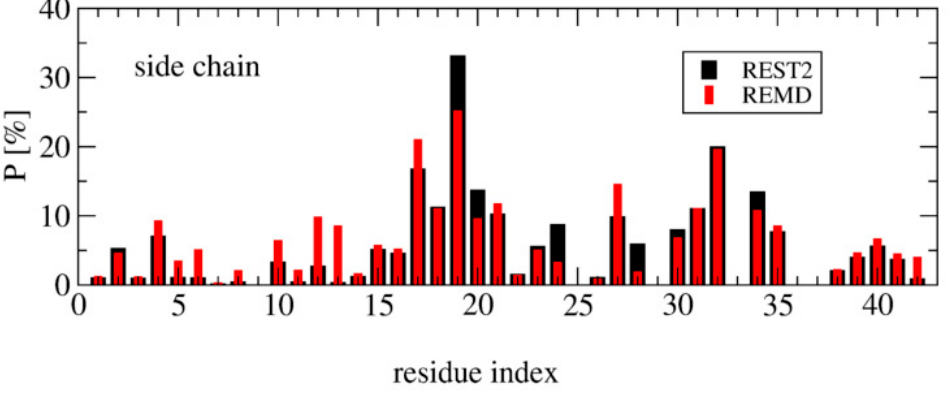
Figure 5. Probability of side-chain contacts between each cholesterol molecule and each amino acid of each A β 42 peptide using the time interval 50–250 ns of REMD at 315 K, and REST2 at 310 K.